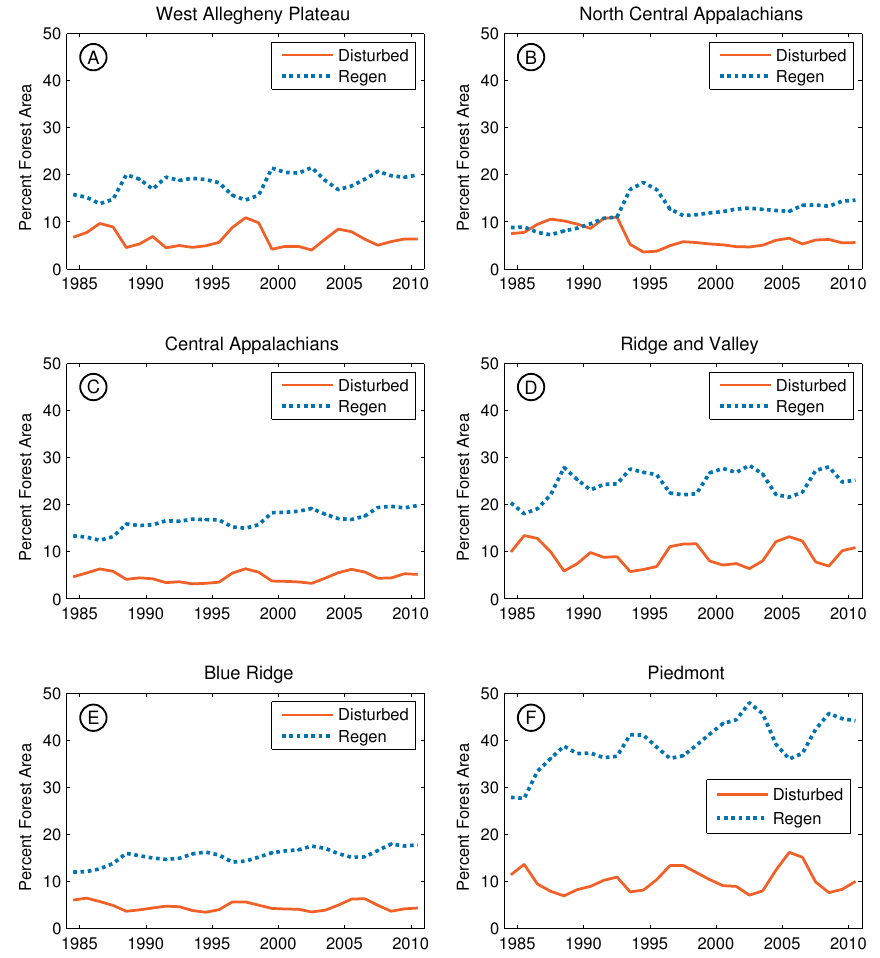
Figure 11. Percent of forested area experiencing disturbance (solid) and regeneration (dotted) by ecoregion ( A – F ) over 28